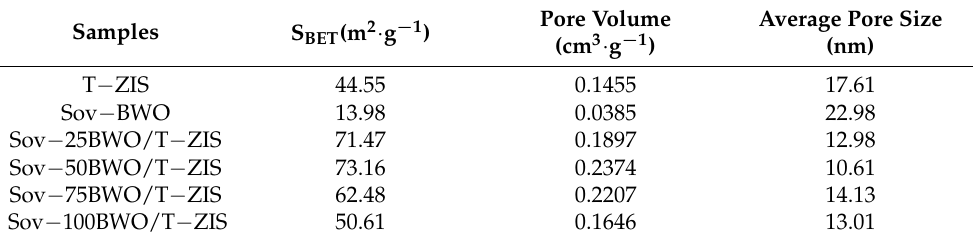
Table 1. The Brunauer–Emmett–Teller (BET) surface area, pore volume and